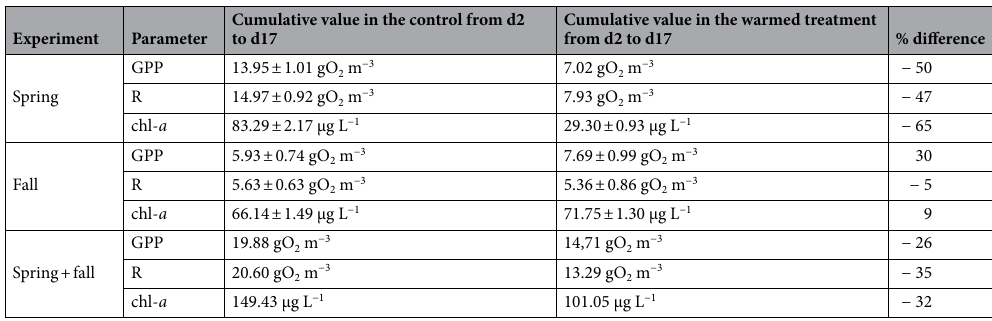
Table 3. Cumulative GPP, R, and chl- a from d2 to d17 in the control and the warmed treatment for the spring experiment, the fall experiment, and when adding both experiments, and relative difference between treatments. GPP gross primary production, R respiration, Chl-a chlorophyll-